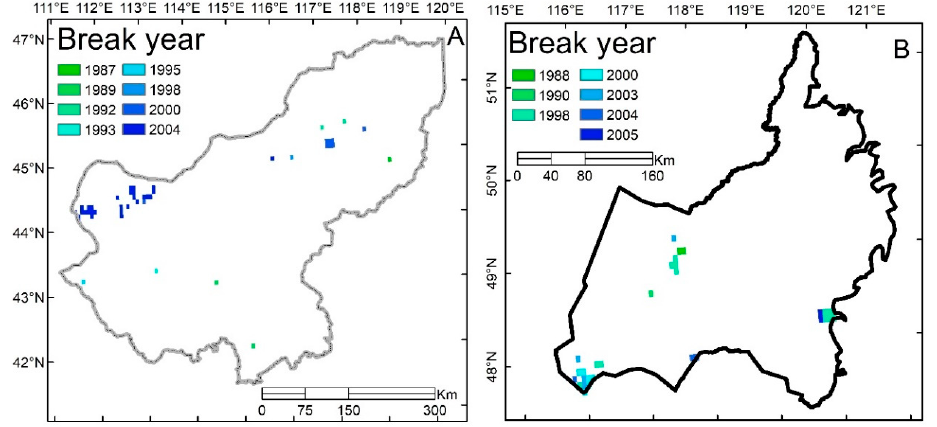
Figure 6. Breakpoints of NDVI detected by BFAST ( A : Xilingol; B : Hulunbuir).